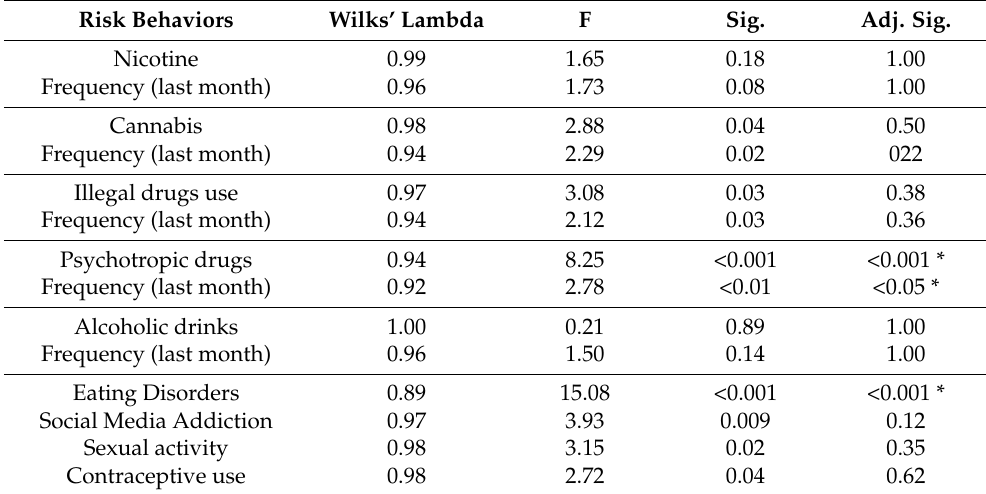
Table 3. Associations between risk behaviors and components of personalized well-being index (PWBI) assessed by multivariate analysis of variance. Risk Behaviors Wilks’ Lambda F Sig. Adj. Sig. Nicotine 0.99 1.65